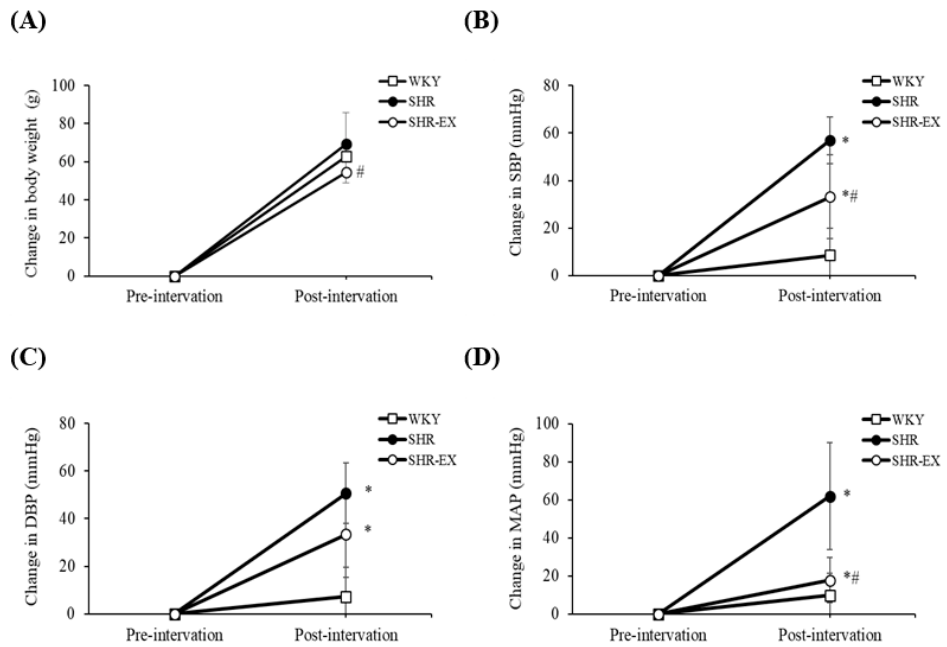
Figure 1. Change in (A) body weight, (B) systolic blood pressure (SBP), (C) diastolic blood pressure (DBP), (D) mean arterial pressure (MAP), pre- to post- exercise training intervention in Wistar-Kyoto rats (WKY), sedentary spontaneously hypertensive rats (SHR), and spontaneously hypertensive rats with exercise training (SHR-EX). Each sub-figure indicates mean values ± SD ( n = 8 in each group). * p < 0.05, significant differences from the WKY group. # p < 0.05, denotes a significant difference between the SHR group and the SHR-EX group.